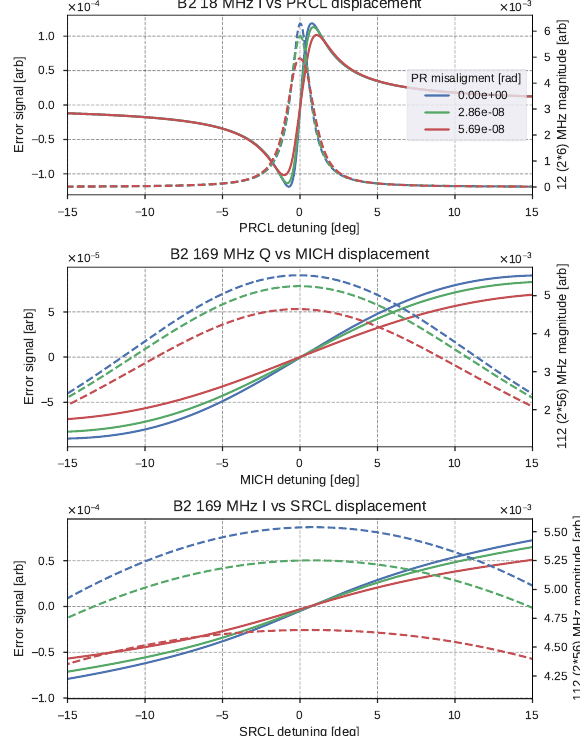
Figure 10. DRMI error signals scans for various PR misalignments. Each plot shows the scan of a different DRMI DOF and its corresponding “3f” error signal (continuous lines). The dashed lines show the “2f” signal magnitude , acquired on B4, corresponding to the resonances of either the 6MHz (first plot) or 56MHz (second and third